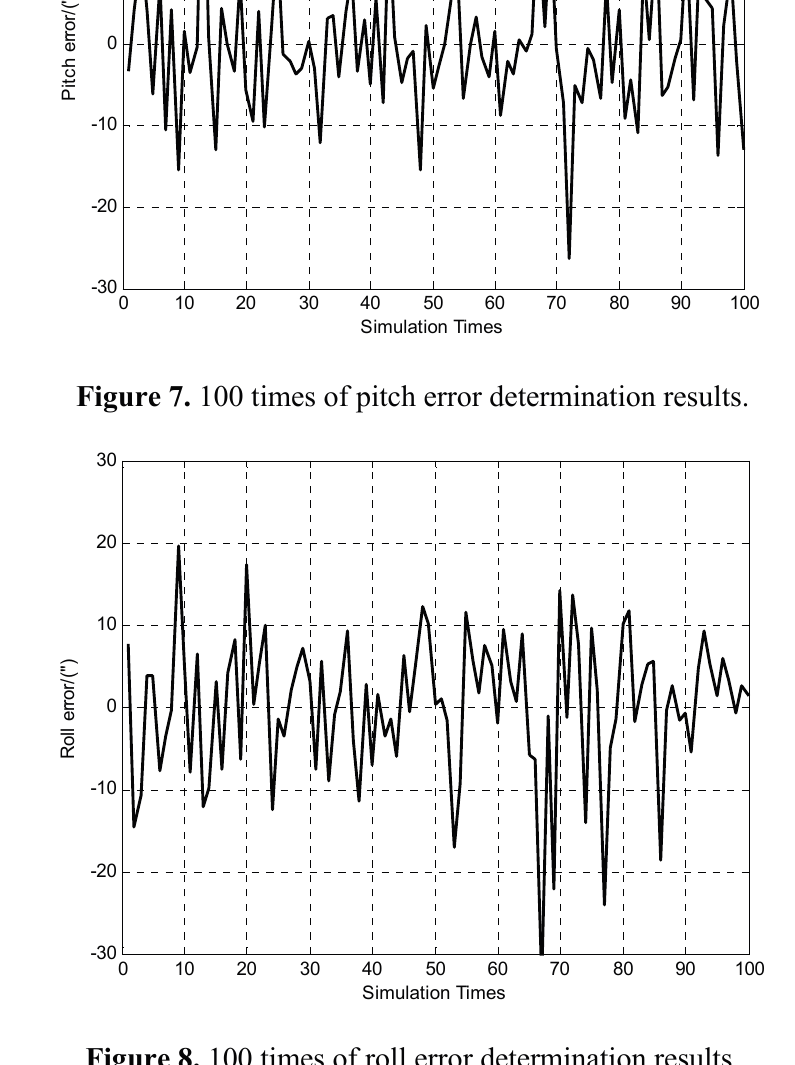
Figure 8. 100 times of roll error determination